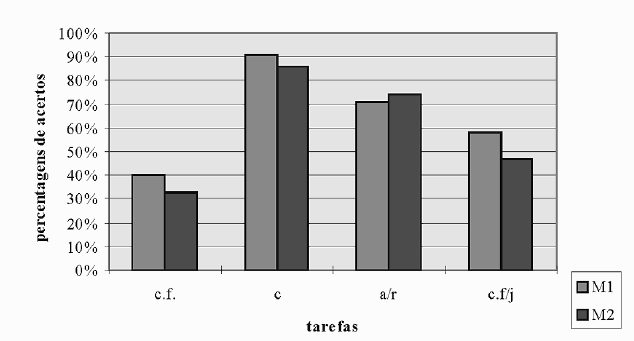
Figura 4. Percentagens de acertos por tarefas e modalidades. Nota. c.f. = cren(cid:231)a falsa c.f/j = cren(cid:231)a falsa com justificativa